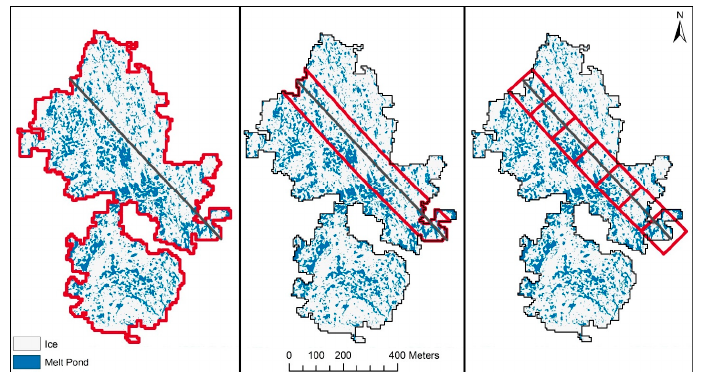
Figure 5. Example comparison of object ( left ), hybrid ( middle ) and grid-cell ( right ) data aggregation approaches. The left panel shows an example of a MYI object (outlined in red), which represents a homogeneous ice zone overlaid on the f p product. The f p product shows melt pond pixels in blue, and ice pixels in white. The gray line represents the track of thickness and roughness data, which intersects the object. Similarly, the middle panel shows a hybrid object (outlined in red) and the right panel shows 120 × 120 m grid-cells centered on the thickness/roughness track. The hybrid objects were created to account for the footprints of the thickness and roughness sensors.